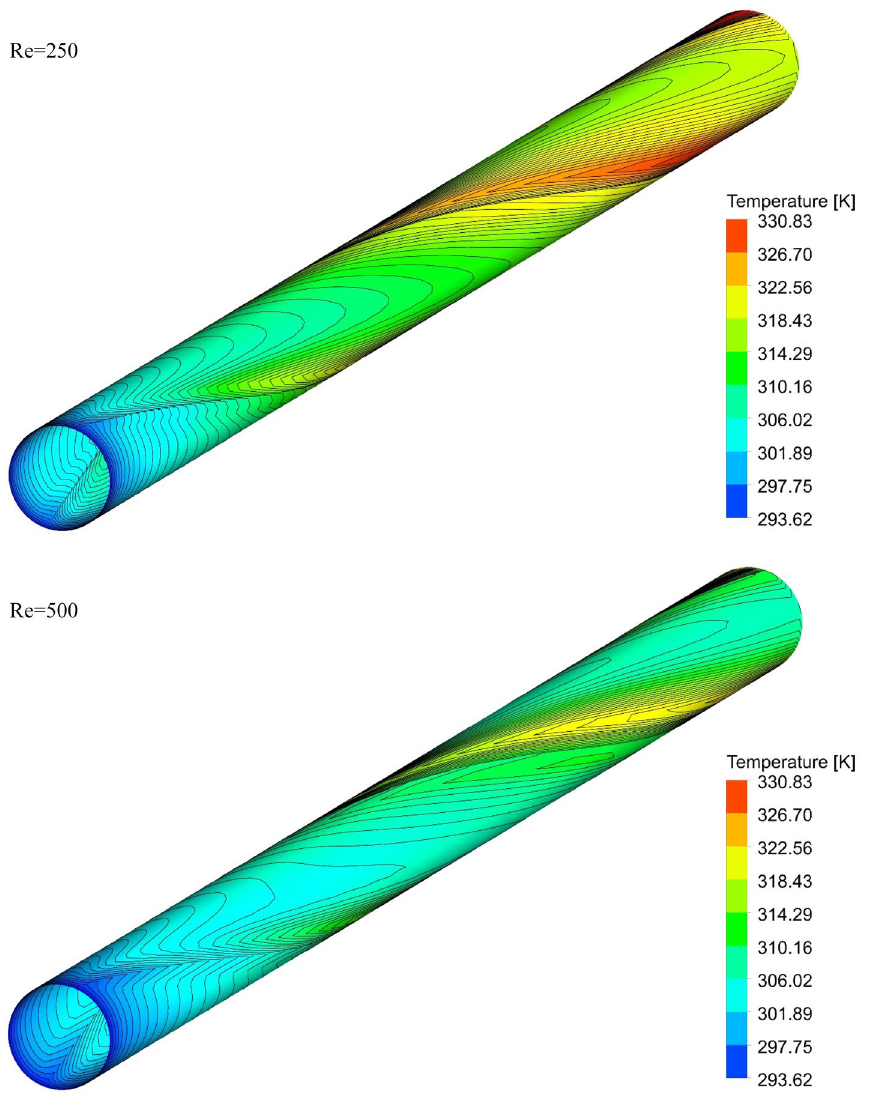
Figure 14. Isotherm contours on the surface of the pipe in φ = 0% and Case